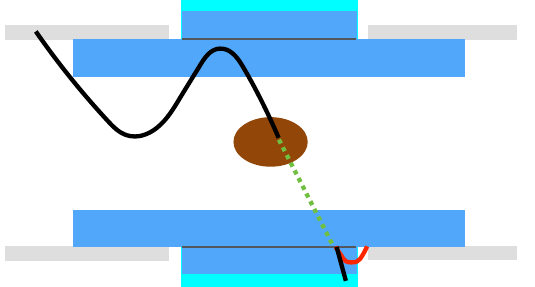
Fig. 6 Sketches of a detector design made of an extended e + and an e + e − pair trackers (sky blue) separated by a thin conversion layer (dark gray, not in scale), with positron (light gray) and photon (cyan) timing